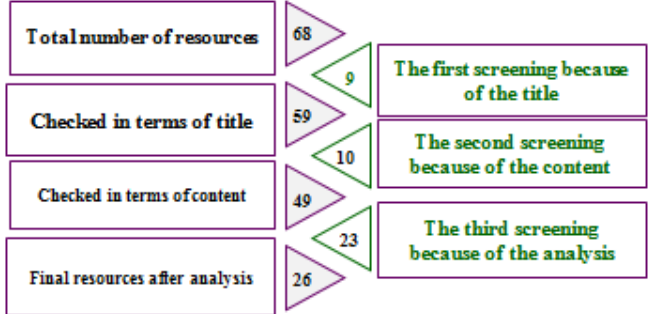
Figure1. Screening of initial